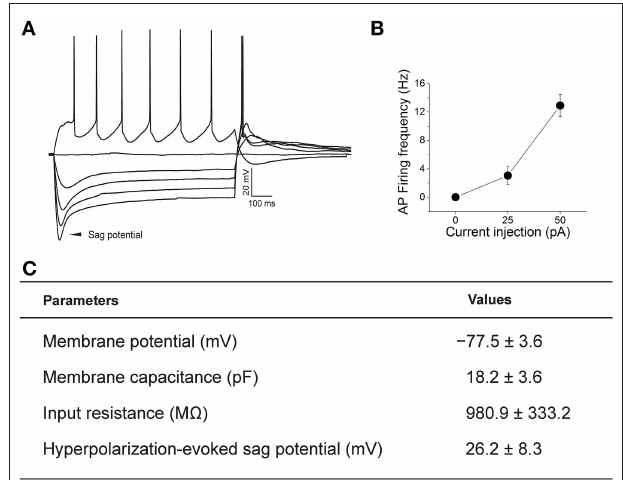
FIGURE 3 | Representative current-clamp recording of a pre-proglucagon (PPG) neuron. (A) Perithreshold current levels were determined by incrementally injecting 1,200 ms-long, 25pA steps of current every 10s, starting at − 100pA. Notice the rebound firing after hyperpolarization and the degree of adaptation in action potential (AP) firing frequency. (B) Plot of injected current vs. mean action potential firing frequency (input-output relationship) for 21 sampled PPG neurons. (C) Basic intrinsic properties of a sampled population of PPG neurons are listed in the chart.